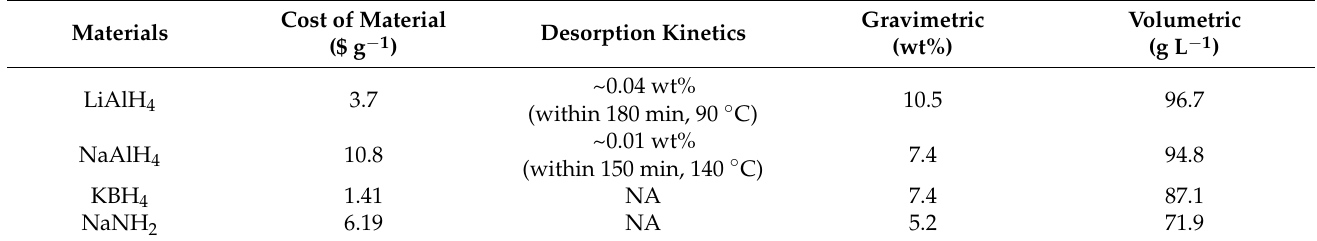
Table 1. Properties of LiAlH 4 and other complex hydrides